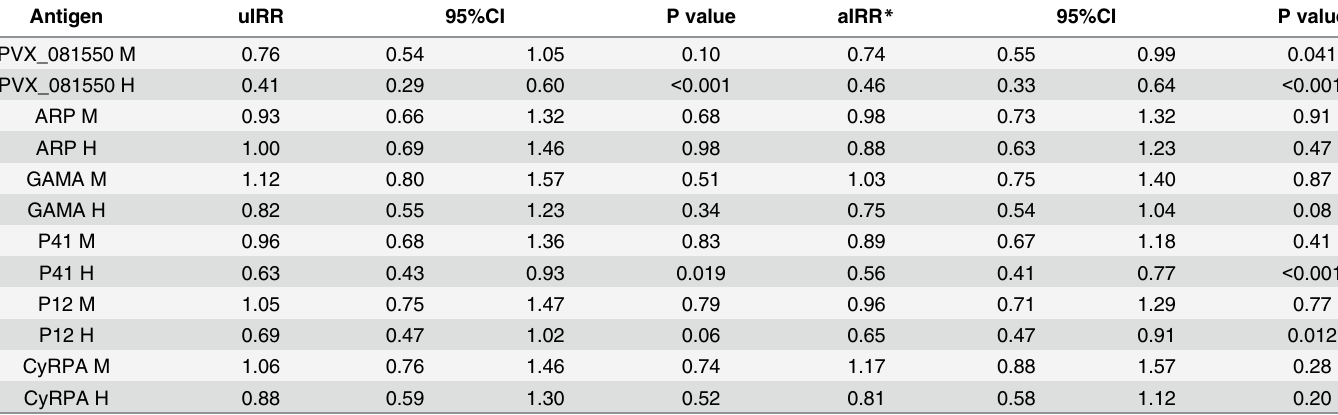
Table 1. Association between levels of IgG to P . vivax merozoite proteins and protection against clinical malaria (with parasite density > 500/ μ L of blood) in Papua New Guinean children. Antigen